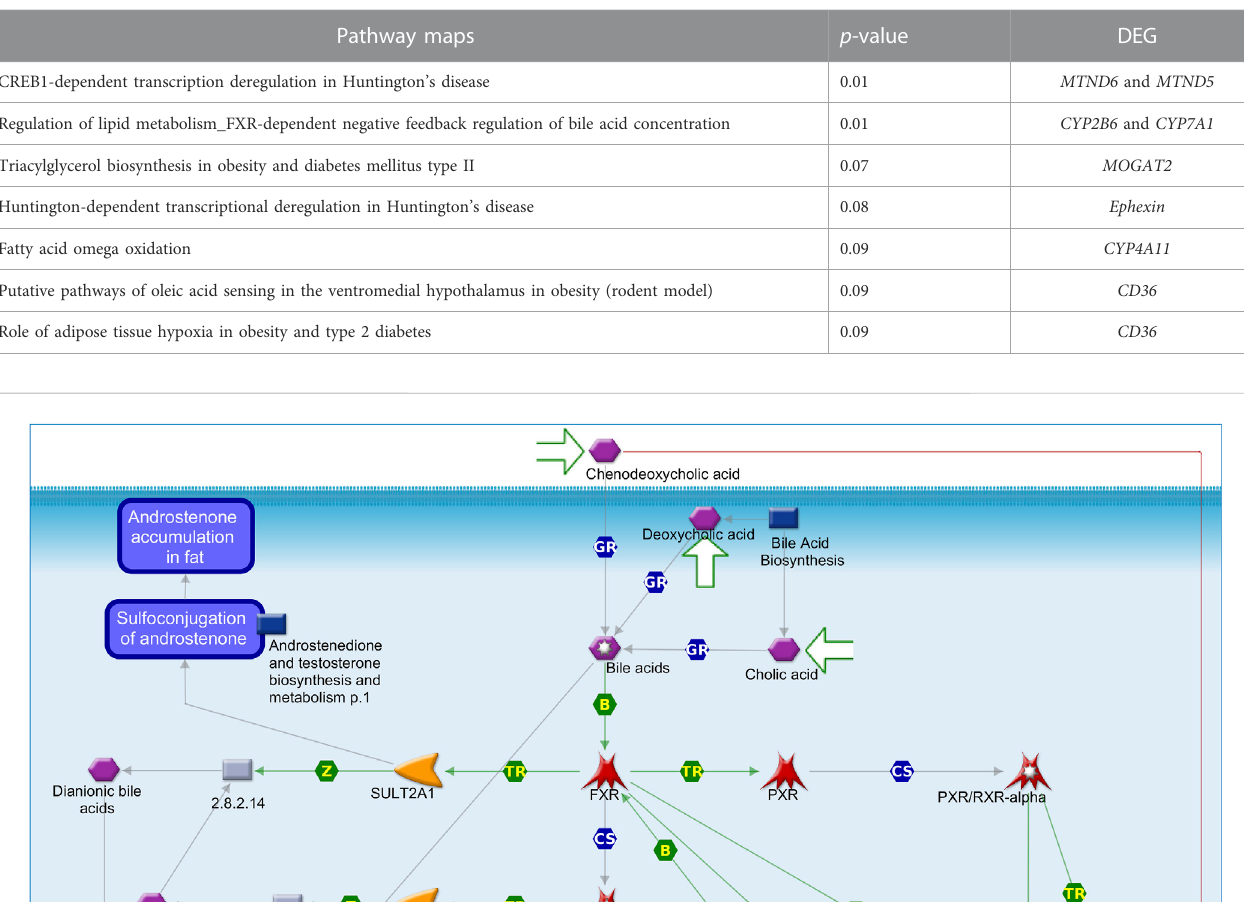
TABLE 4 Pathway maps from the list of differentially expressed genes (FDR 10%) in the liver of male pigs fed with different oil sources found using MetaCore software ( p -value < 0.10).